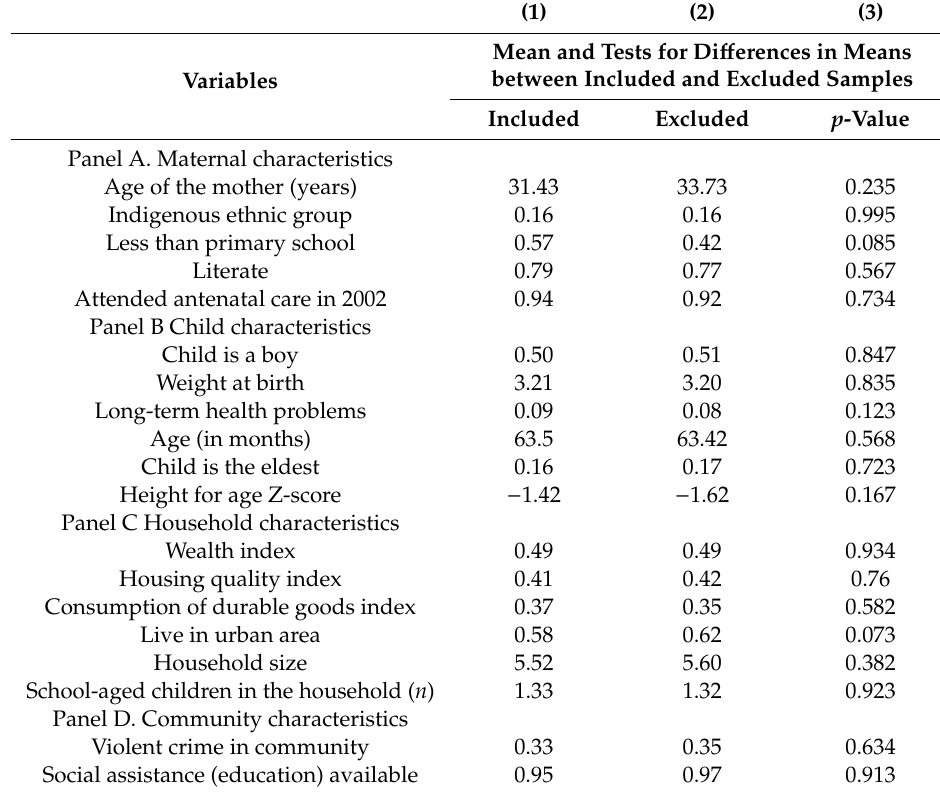
Table A1. Tests for di ff erences between included and excluded